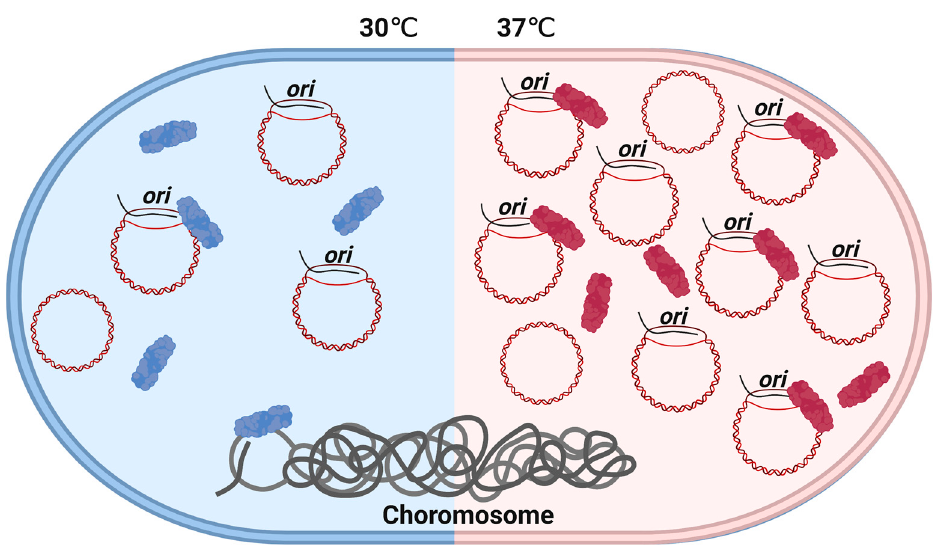
Figure 3. Figure 3. Temperature-dependent Cas3/CRISPR functions in E. coli and the E. coli Δ hns strain. A. —Cas3 stimulates uncontrolled ColE1 plasmid replication in a temperature-dependent manner.